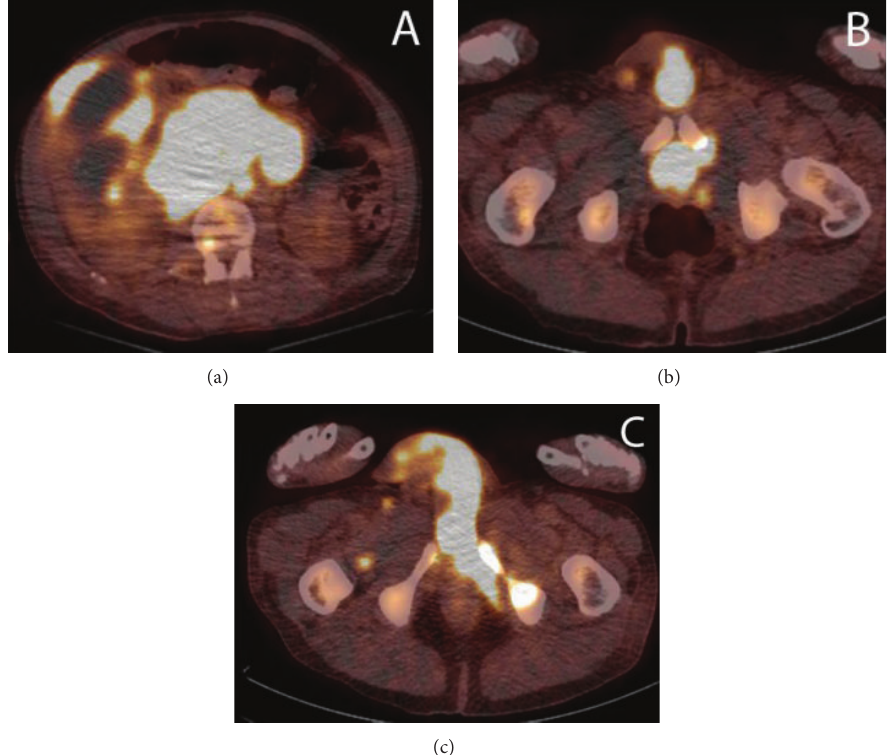
Figure 2: (a) Evidence of intense FDG uptake in the right kidney as well as retroperitoneal lymph nodes. (b) Intense FDG uptake in the prostate with extension to the base of the penis. (c) Intense FDG uptake in the base of the penis with minimal extension into the